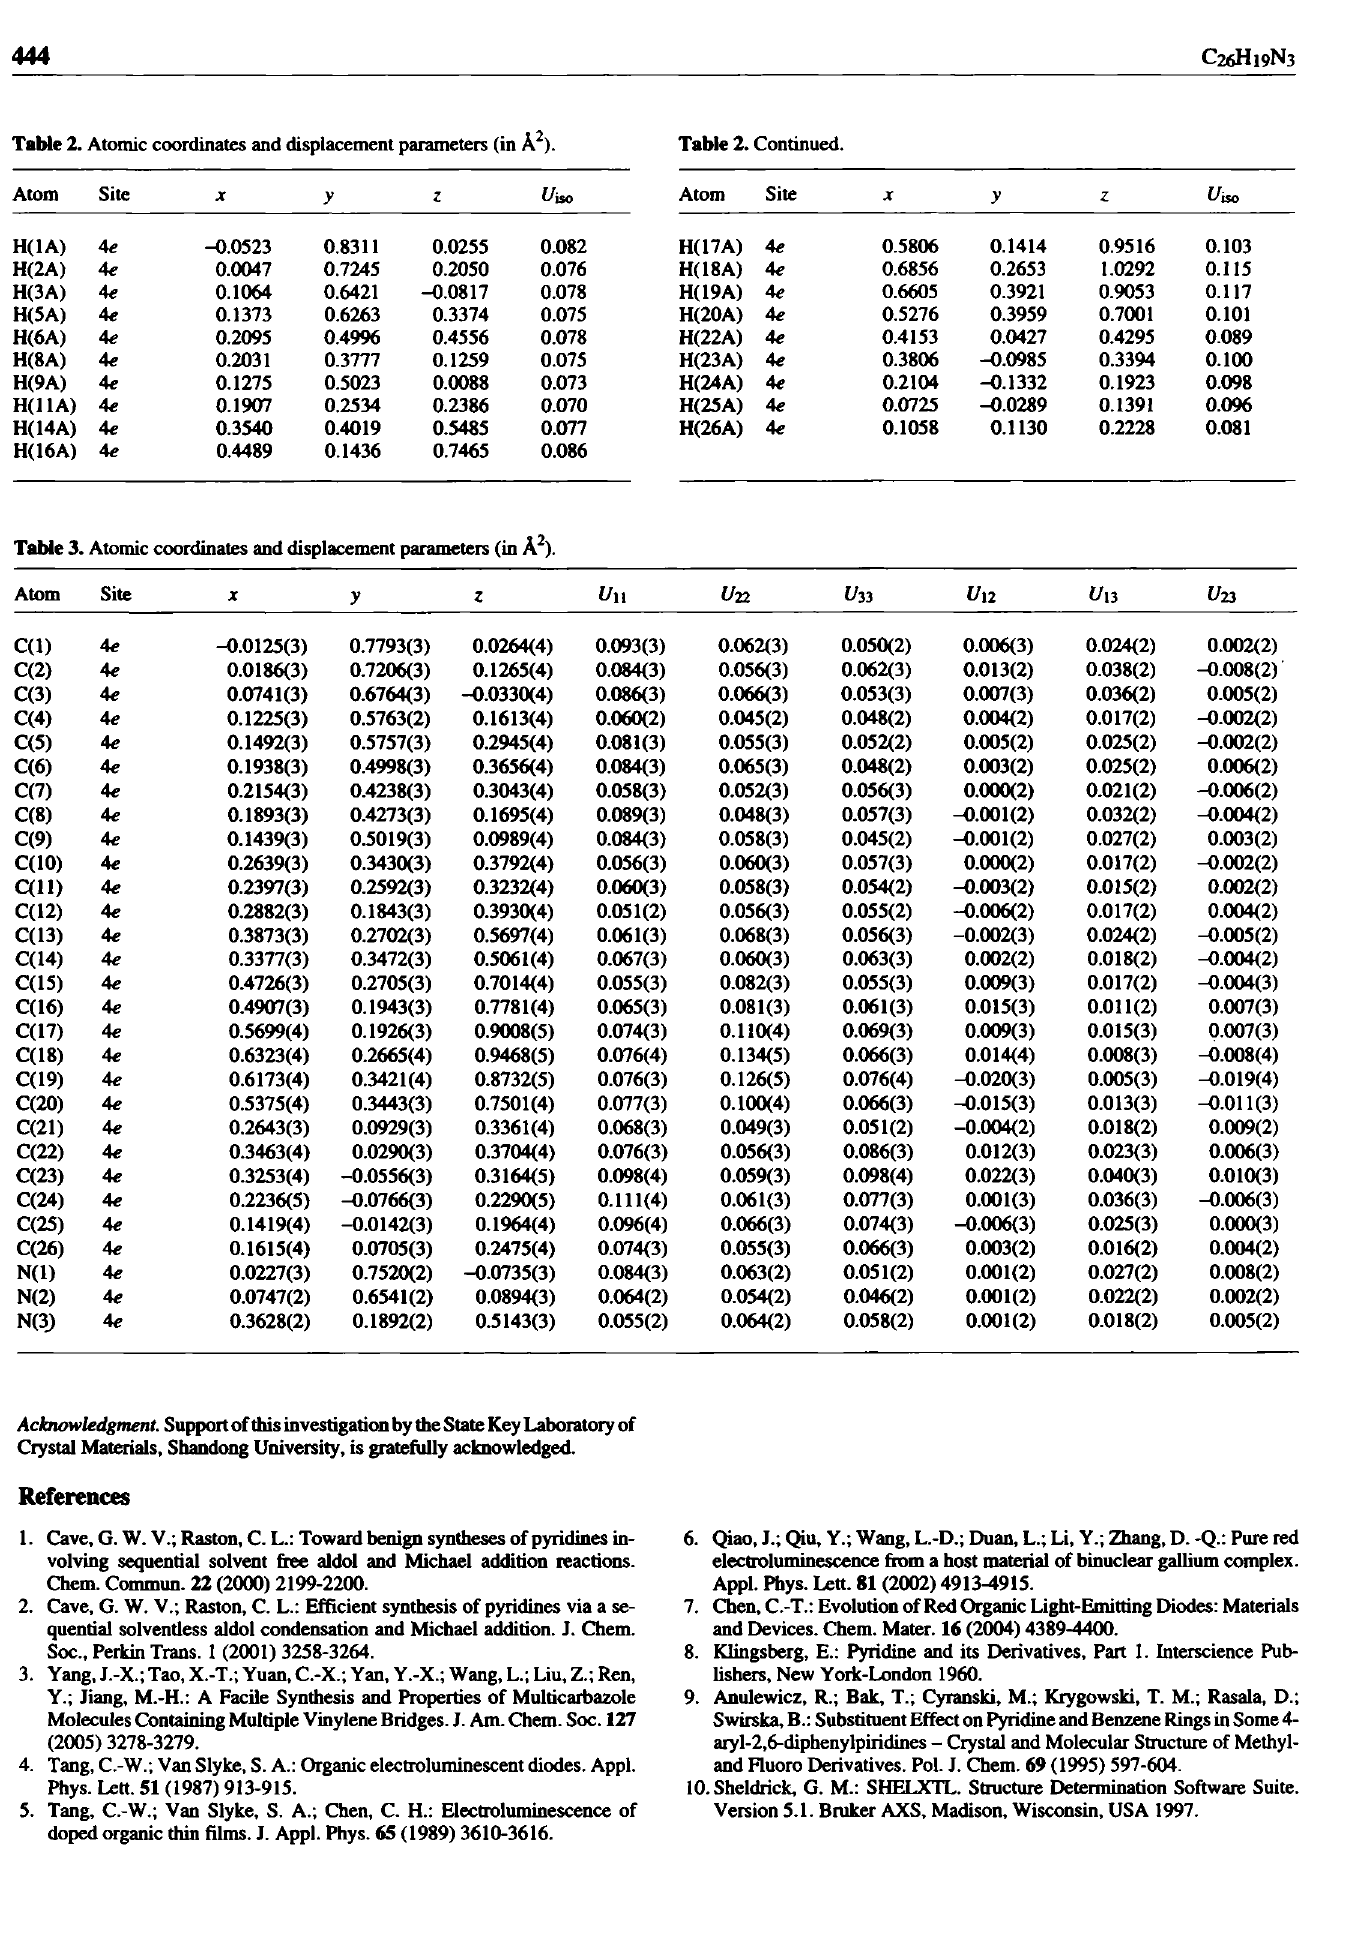
Table 2. Atomic coordinates and displacement parameters (in Ä 2 ).